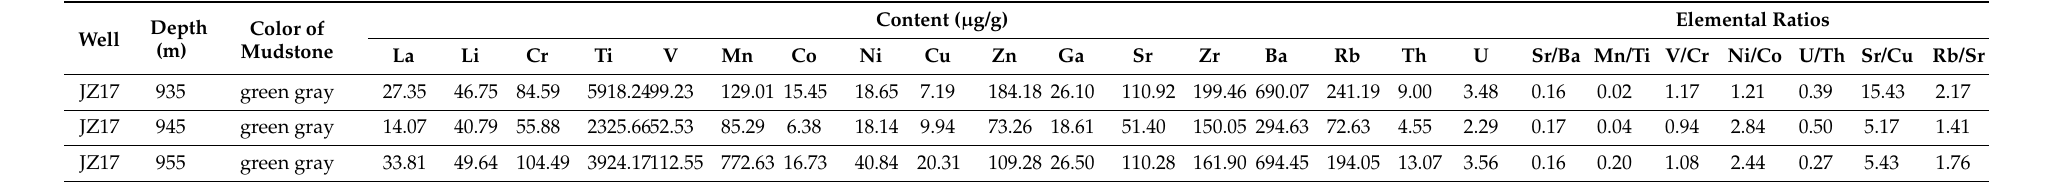
Table 2. Data of trace elements and La in the mudstones of the Guantao